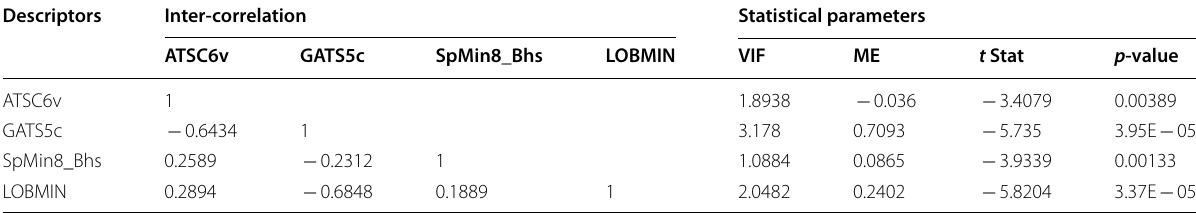
Table 7 Pearson’s correlation and statistical analyses of descriptors used in the QSAR